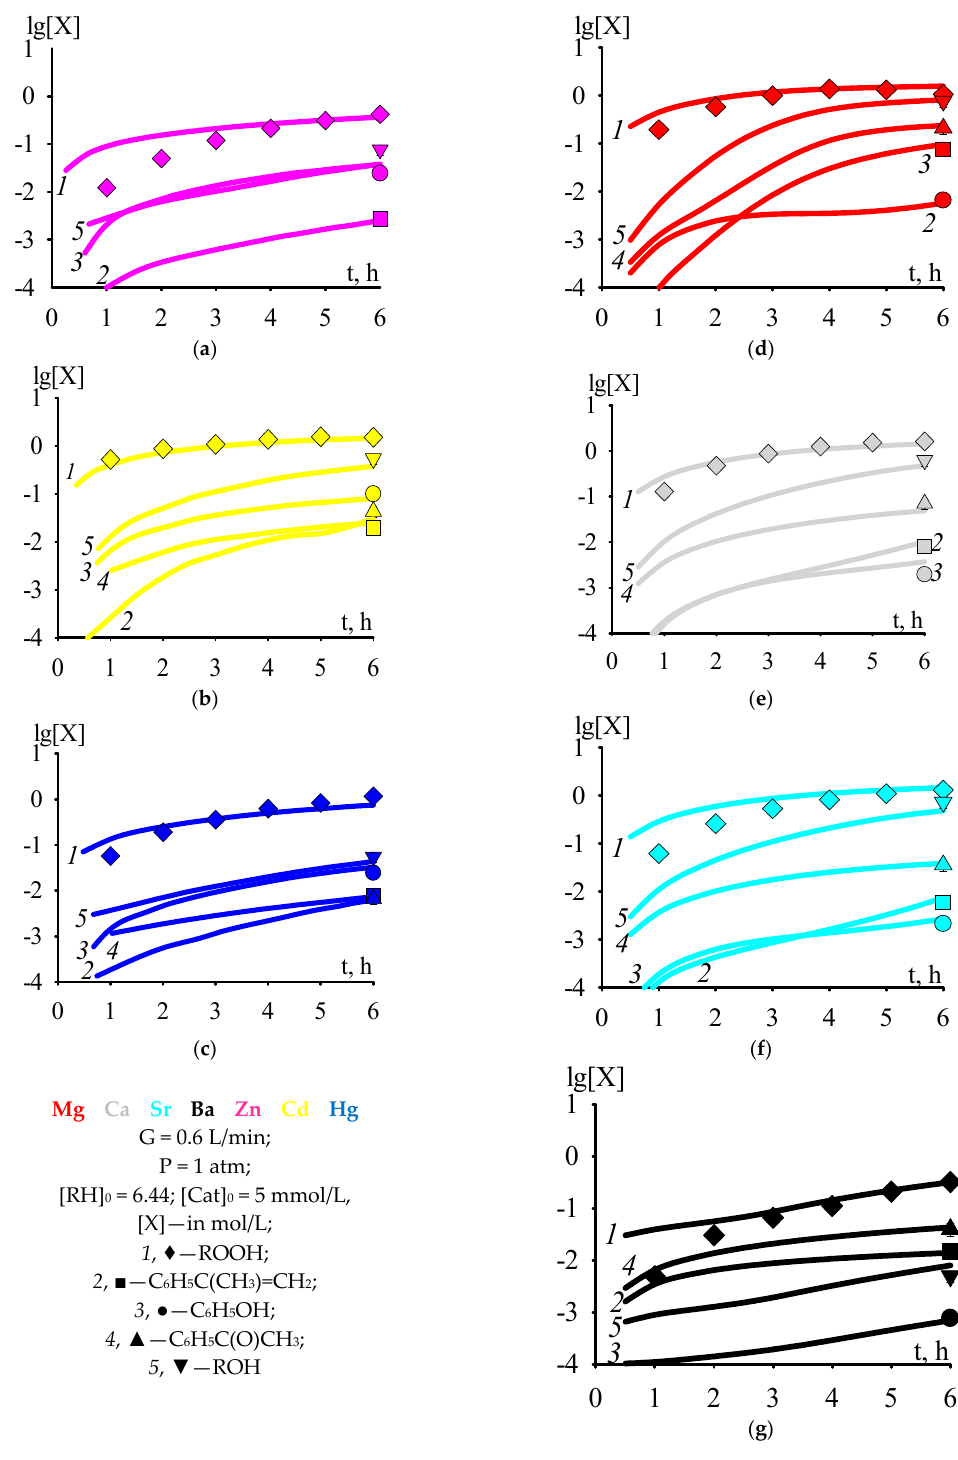
Figure 1. The dependencies of the concentrations of cumene hydroperoxide and by-products in cumene oxidation versus time; T = 383 ( a – c ), 393 ( d – g )